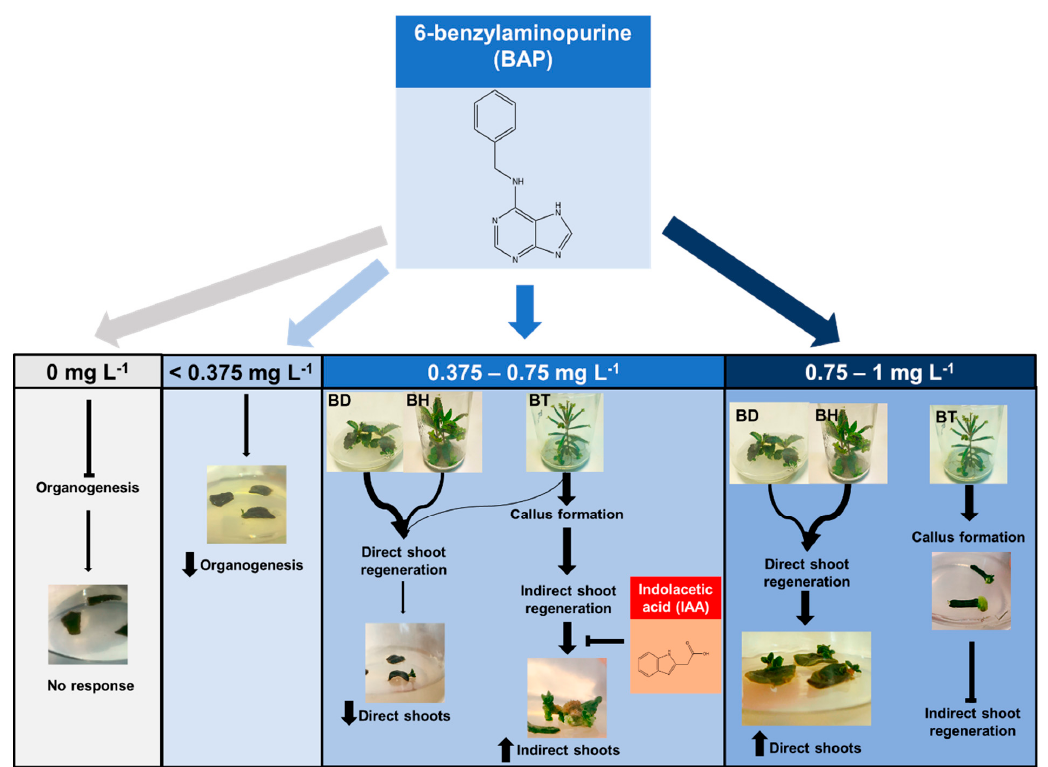
Figure 2. Proposed mechanism of action of the phytohormones BAP and IAA on the in vitro organogenesis of Bryophyllum spp., based on the predictive model generated by ML models.